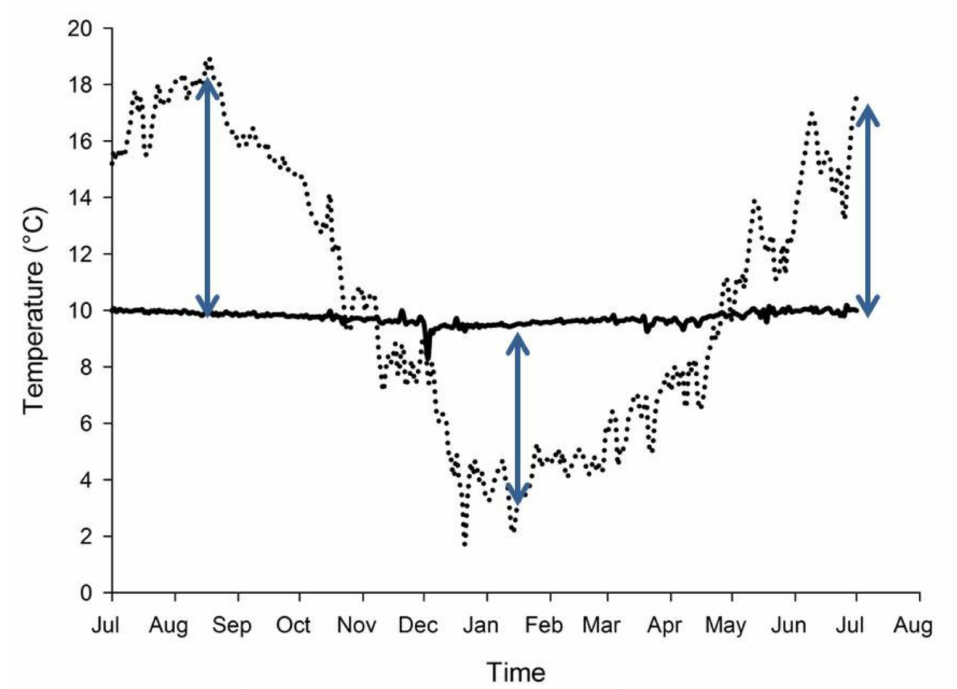
Figure 5. Comparison of thermal fluctuations on a volcanic spring-fed river (solid line) and runoff river (dotted line) in northern California, USA. Arrows indicate typically stressful periods for fish and other coldwater biota. (Adapted from